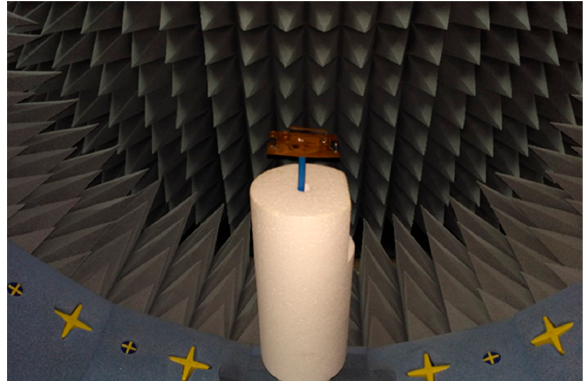
Figure 5. Far-field-characteristic measurement of the antenna in the Satimo near-field measurement Figure system.